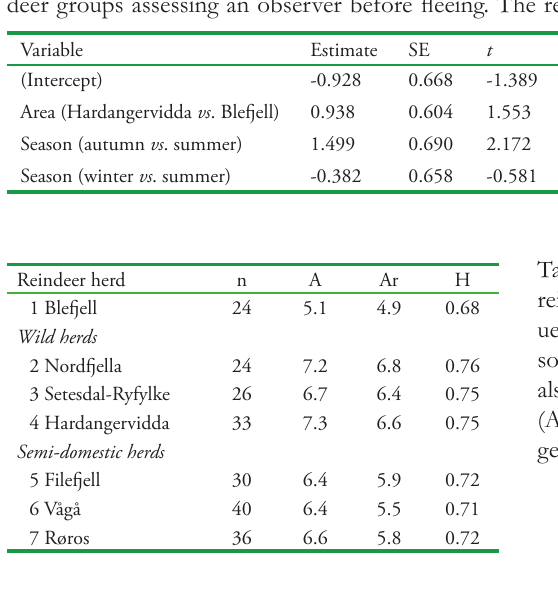
F are given above the diagonal and ST significance of differentiation in allele frequencies below the diagonal. Sig- nificant allele frequency differentia- tion (Benjamini-Hochberg corrected for multiple tests) is marked with as- terisk.